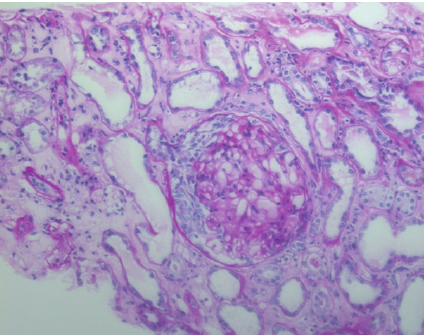
Figure 1: Periodic acid-Schiff stained histologic preparation with an overview of the renal parenchyma. The glomerulus shows a cellular crescent. The glomerular tuft shows mesangial hypercellularity. Tubular cells are damaged with regenerative features (PAS, × 200).